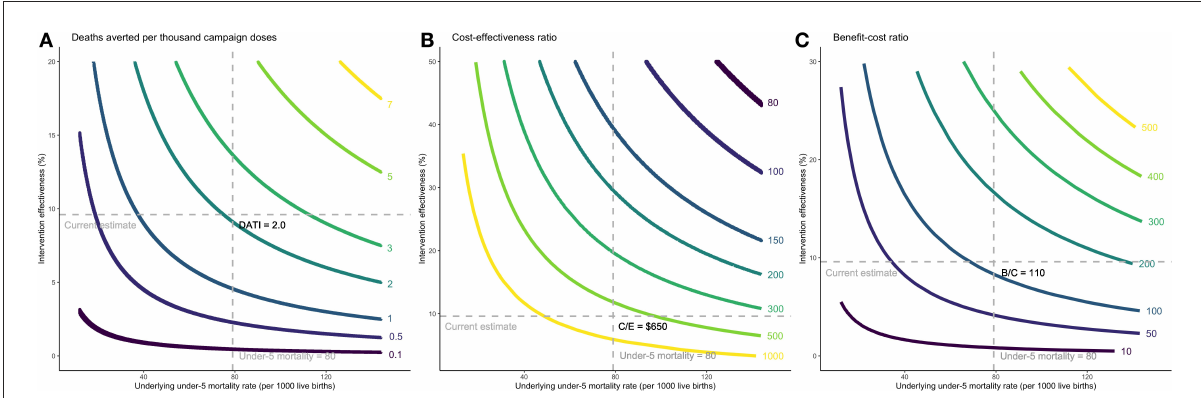
FIGURE1 Cost-effectiveness and benefit-cost ratios per child death averted by background mortality and intervention effectiveness. Headline assumptions about parameter values are denoted by the dashed lines. (A) Incremental deaths averted per thousand campaign doses. (B) Incremental cost-effectiveness ratio per averted death. (C) Incremental benefit-cost ratio. The intervention was studied among children under 3 years of age, consistent with the scientific literature, and the results are estimated based on under-3 mortality rates. Since under-5 mortality rate is a more commonly used indicator, we extrapolated the under-3 mortality rate to under-5 mortality rate in the x-axes by multiplying it by the ratio of global average of under-5 to under-3 mortality. (A) Each curve shows combinations of the underlying under-5 mortality rate and intervention effectiveness that makes deaths averted per 1,000 campaign doses (DATI) constant along the curve. For example, the yellow curve on the top right shows combinations that result in 7 deaths averted per one thousand campaign doses administered. (B) Cost-effectiveness ratio (C/E) is expressed as cost per child death averted. For example, the yellow curve on the bottom left shows combinations that result in $1000 per child death averted. (C) The benefit-to-cost ratio (B/C) is the ratio of the dollar value of benefits to the dollar value of costs. For example, the yellow curve on the top right shows combinations that result in a benefit-to-cost ratio of